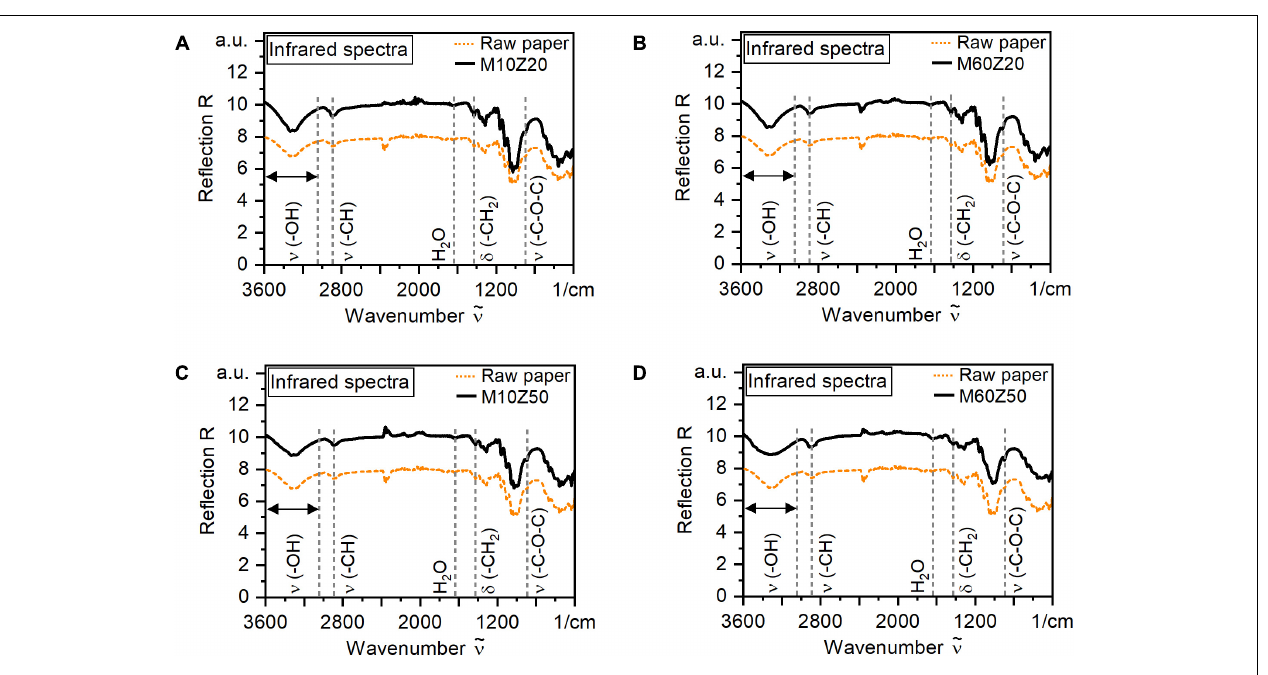
spectra were collected in a wavelength interval between 3,600 and 400 cm − 1 and all of them show the characteristic peaks for cellulose. In the interval between 3,600 and 3,100 cm − 1